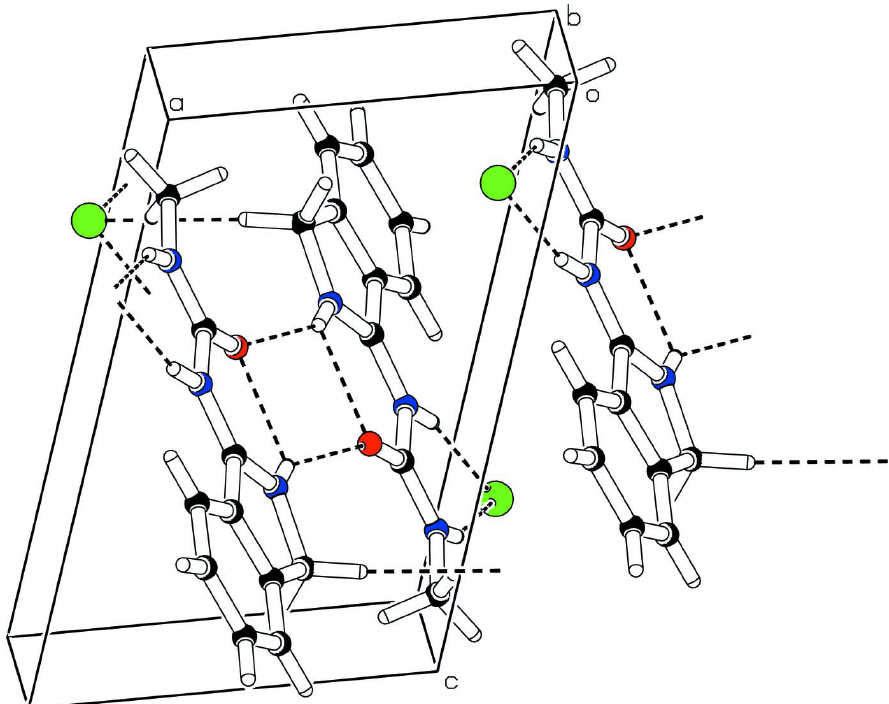
Figure 2 The packing of I ( PLATON : Spek, 2003) showing the dimers and H-bonds to the chlorine anion. H-bonds are indicated by broken